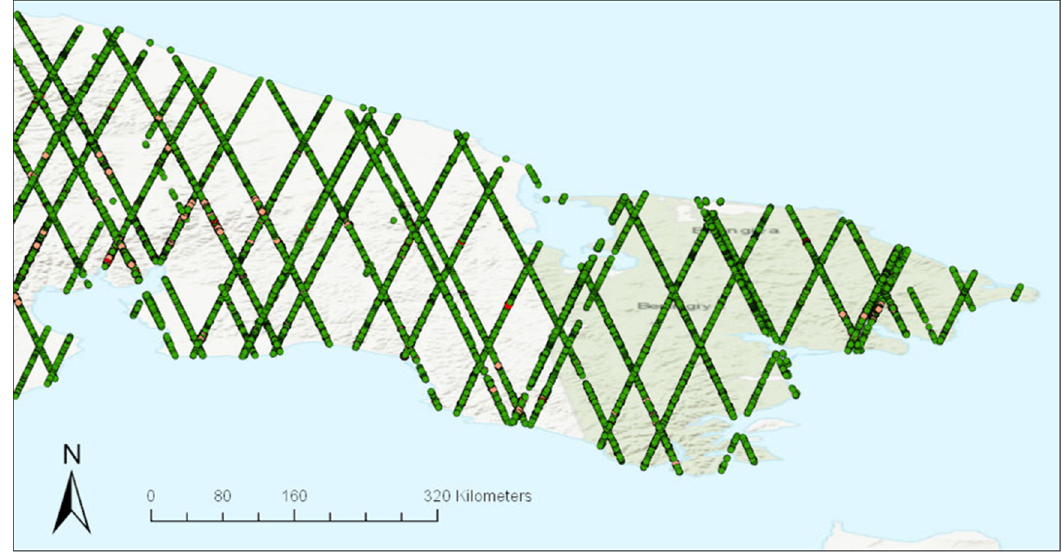
Figure 6. ICESat-1 points that were used to confirm WorldDEM’s accuracy in northeast Russia. Table 6. Comparative results using WorldDEM and ICESat-1 as reference datasets in northeast Russia. Mean STD Range Reference Dataset Collection-2 1